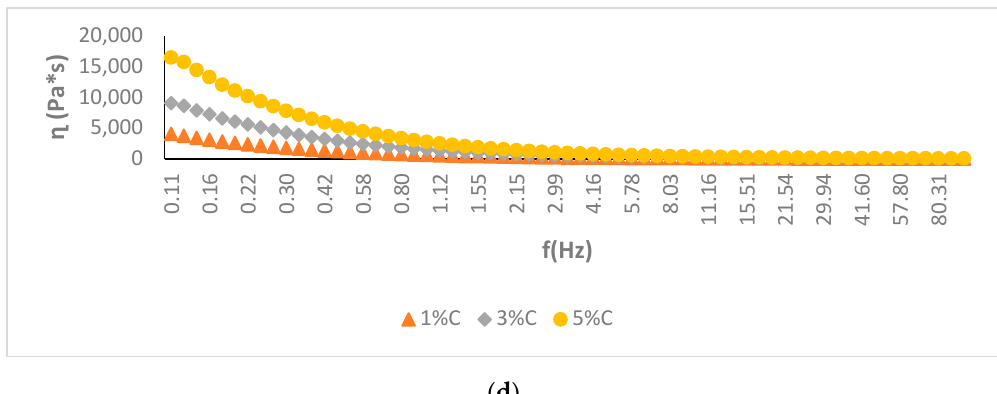
Figure 1. Effect of different dried vegetable powders and amounts (1, 3, 5%) on the viscosity of fat ‐ free dairy desserts. Letters ( a – d ) describe different desserts: ( a ) with beetroot powder (Be); ( b ) with onion powder (O); ( c ) with champignon powder (Ch); and ( d ) with carrot powder (C).